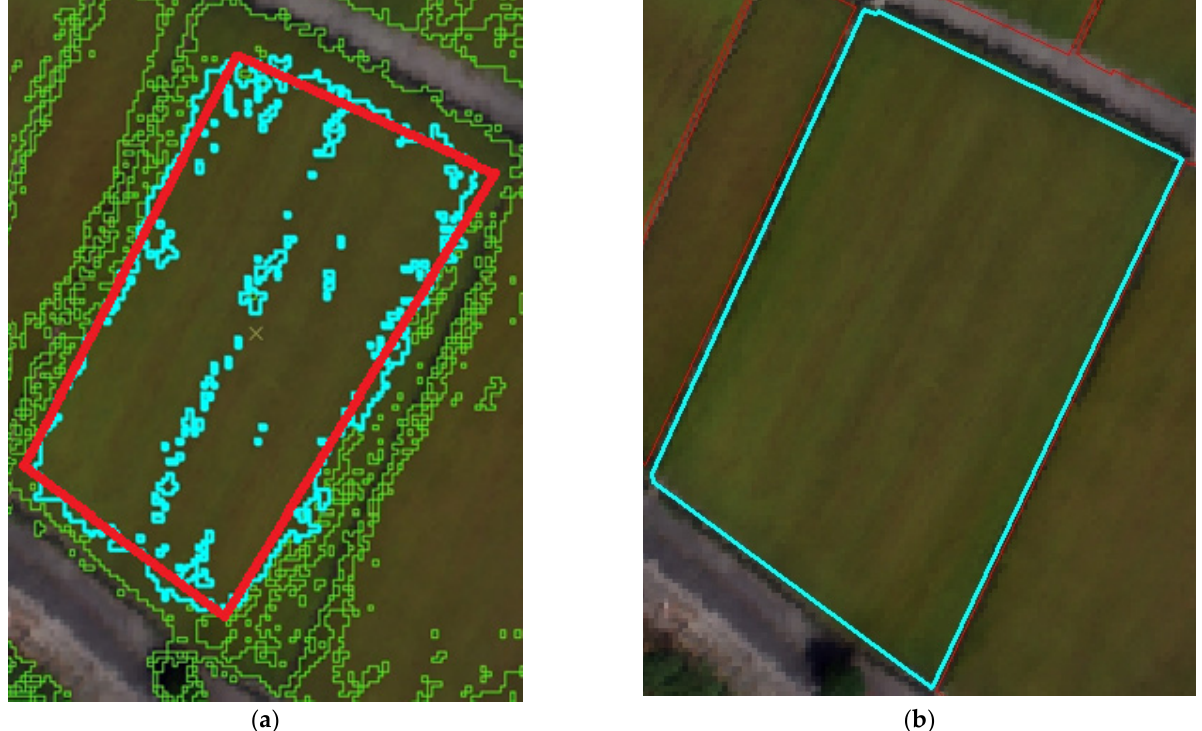
Figure 4. The progress of the Cell program derived from the regional object classification model (ROC) program. The line is represent the margin of linear regression function by collecting the coordinate data of blue pixels: ( a ) The ROC program find seeds of Area and Similarity. ( b ) Removal of the tiny parts to be integrated.